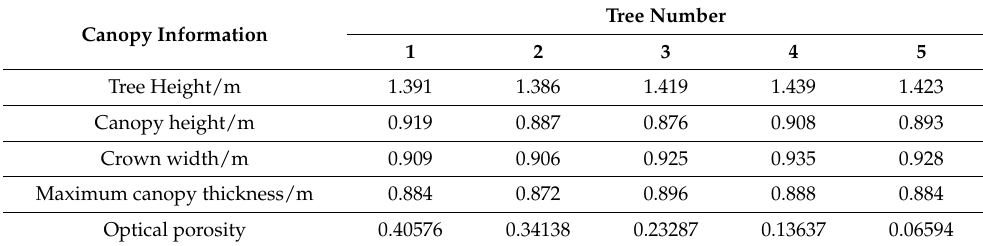
Table 1. Canopy characteristics and optical